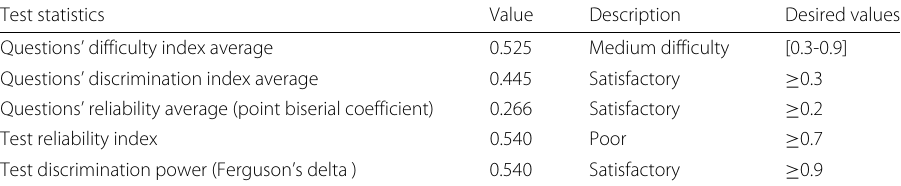
Table 16 Test-one analysis (number of students’ attempts = 126)